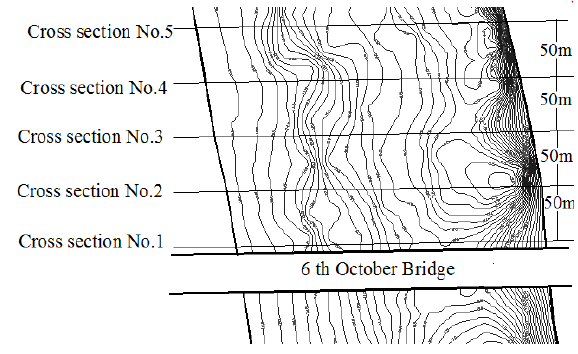
Figure 9. The places of the cross sections